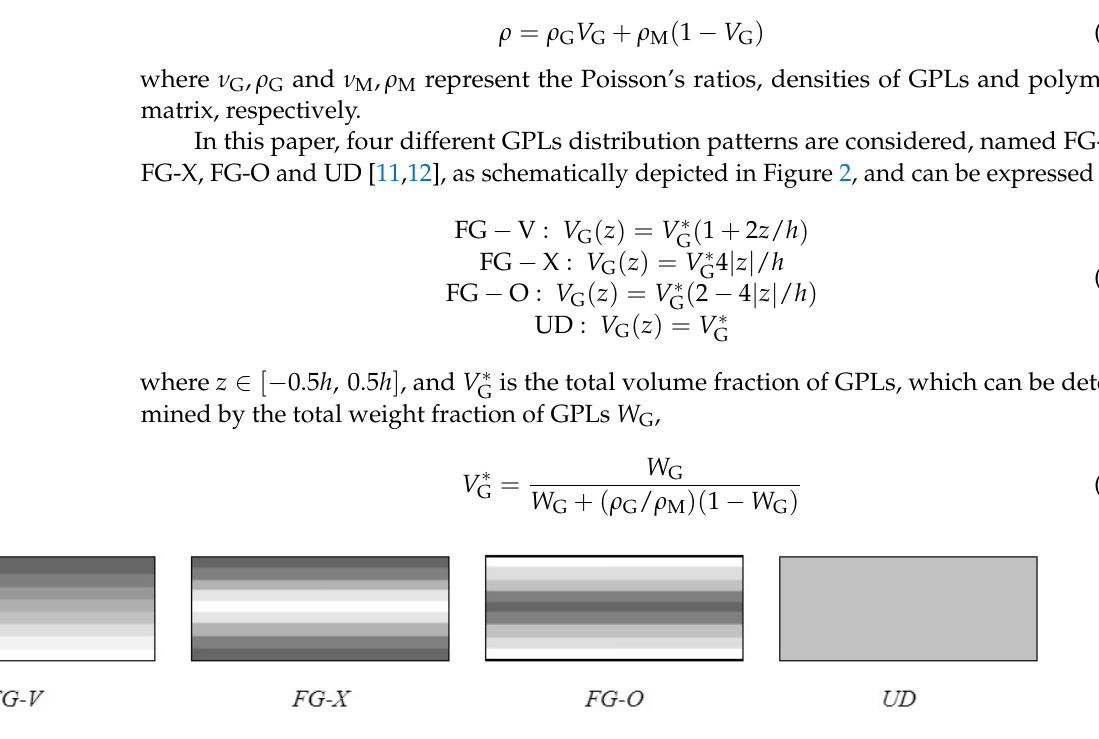
Figure 2. Different GPL distribution patterns.